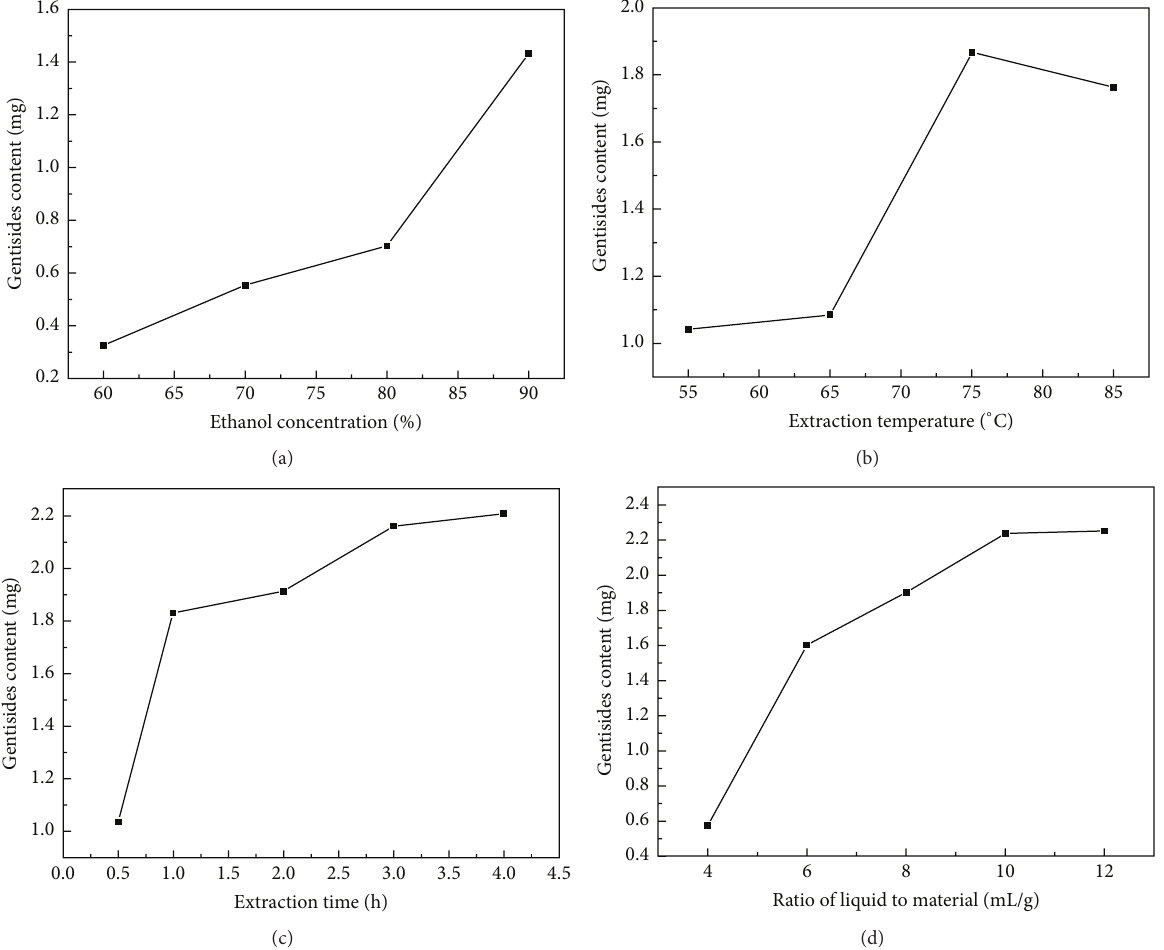
Figure 3: Experimental results of univariate test in four kinds of extraction conditions; (a) effect of the ethanol concentration selected as 60%, 70%, 80%, and 90%; (b) effect of the extraction temperature set at 55, 65, 75, and 85 ∘ C; (c) effect of the extraction time set at 0.5, 1, 2, 3, and 4h; (d) effect of the ratio of liquid to material selected as 4, 6, 8, 10, and